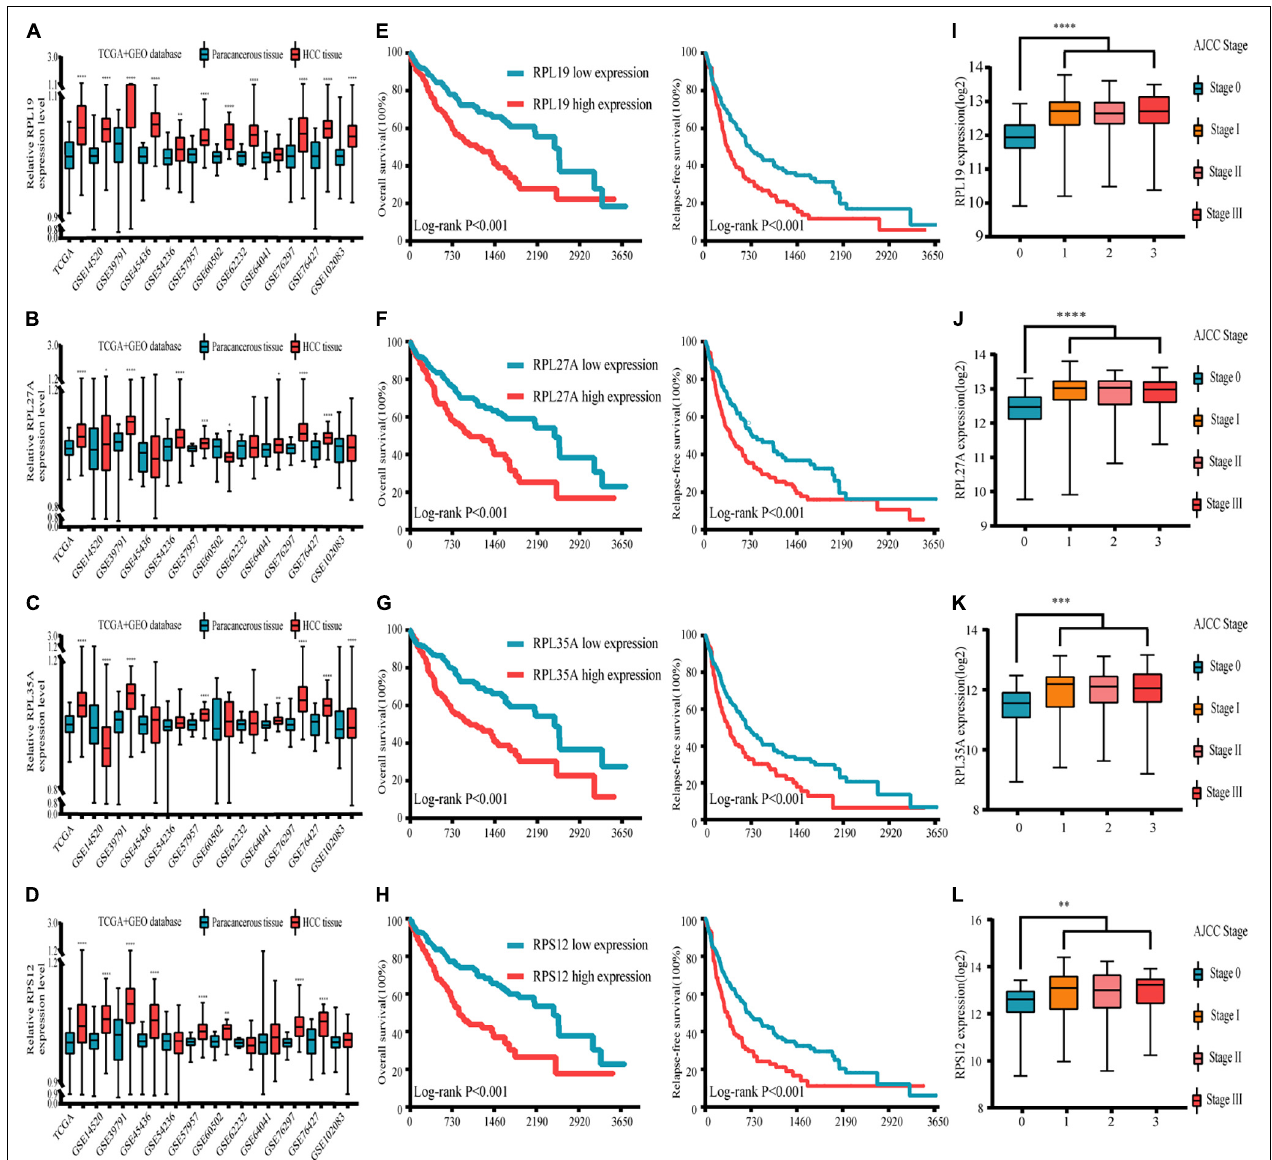
FIGURE 4 | Expression, clinicopathological and prognostic analyses of the four hub genes in the GEO and TCGA databases. (A–D) Expression of the four hub genes in the GEO and TCGA databases. (E–H) Relationship between the expression levels of the four hub genes and the OS and RFS of HCC patients. (I–L) Expression levels of the four hub genes in different AJCC stages of HCC. TCGA database and 11 GEO datasets (including GSE14520, GSE39791, GSE45436, GSE54236, GSE57957, GSE60502, GSE62232, GSE64041, GSE76297, GSE76427, and GSE102083) were used for analysis in this section. Differences between two groups were analyzed by Student’s t -test. The OS and RFS of HCC patients were calculated with Kaplan–Meier curves. GEO, Gene Expression Omnibus; TCGA, The Cancer Genome Atlas; OS, overall survival; RFS, relapse-free survival; HCC, hepatocellular carcinoma; GSEA, gene set enrichment analysis. * P < 0.05, ** P < 0.01, *** P < 0.001, **** P <